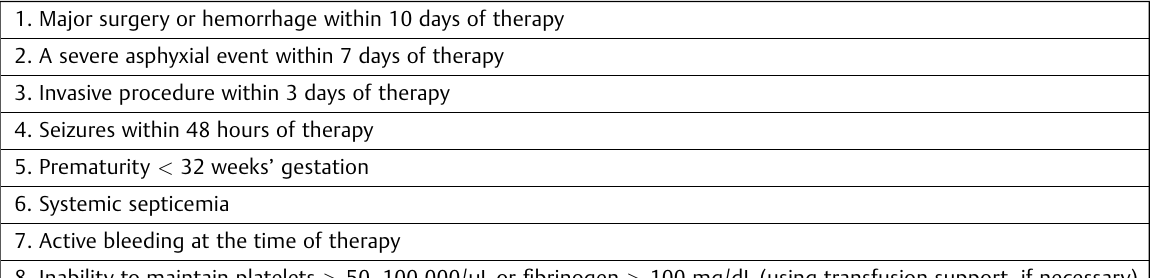
Table 1 Standard contraindications of t-PA